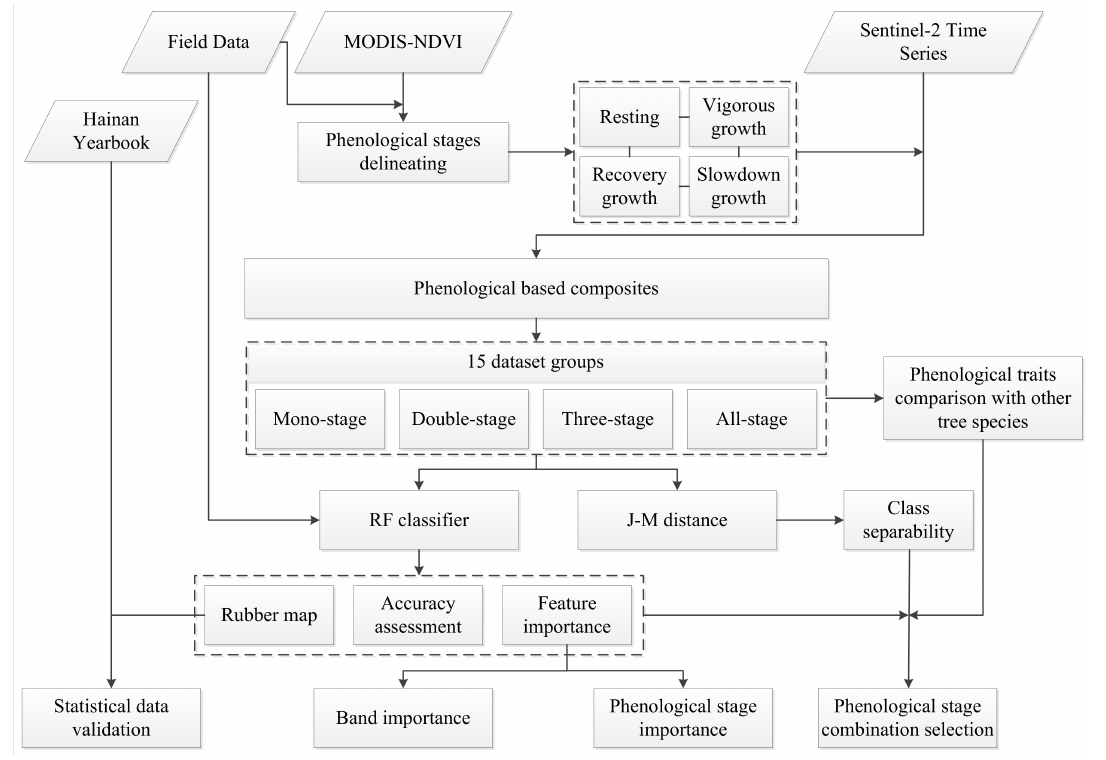
Figure 4. The framework of rubber plantation mapping for the study area using phenology-based Sentinel-2